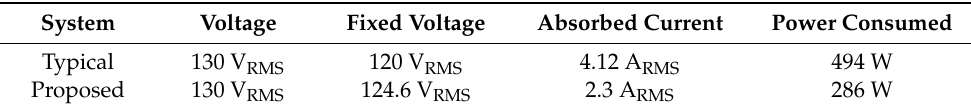
Table 2. Comparison between different voltage regulation strategies.